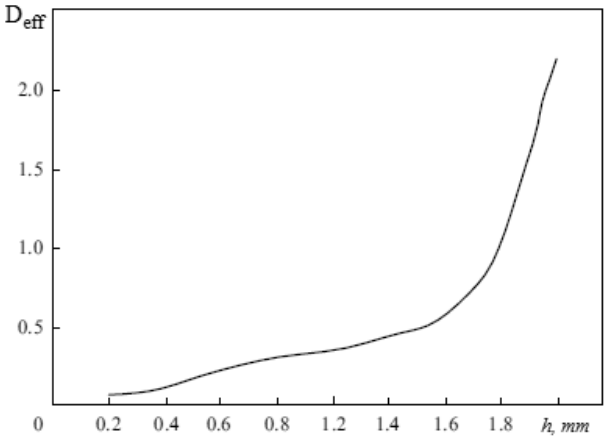
Fig. 5. Dependence of the minimum resolved e®ective diam- eter ð D Þ of necrotic formations on the implant ¯ber surface, normalized to the mesh ¯ber diameter, on the mesh location depth ð h Þ .